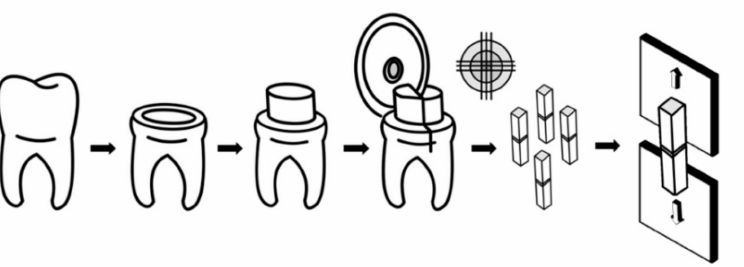
Figure 1. Diagram of the tooth preparation, resin composite placement, specimen preparation, and microtensile bond strength test (modified from Armstrong S et al., 2017) [17].